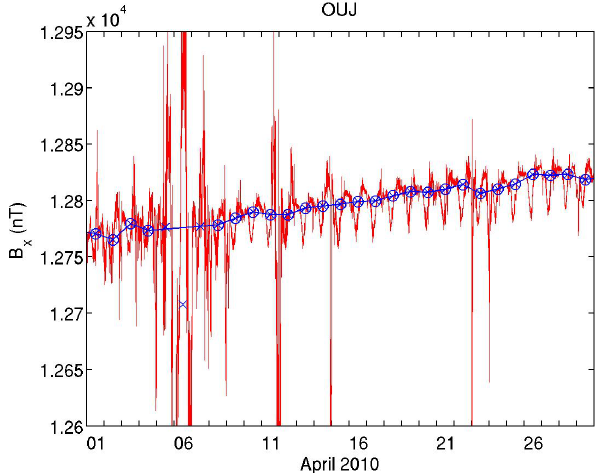
Fig. 6. B x field in Oulujärvi in April 2010 (red), the daily median values (blue x), the ones that are qualified to be used for the long- term baseline (circles), and this baseline B T (t) (blue solid